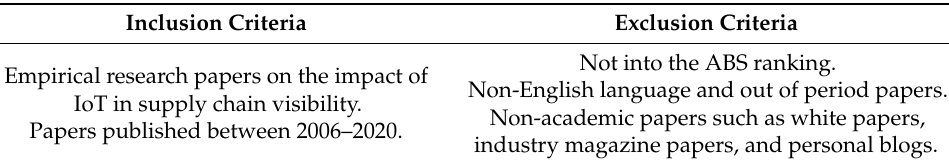
Table 2. Inclusion and exclusion